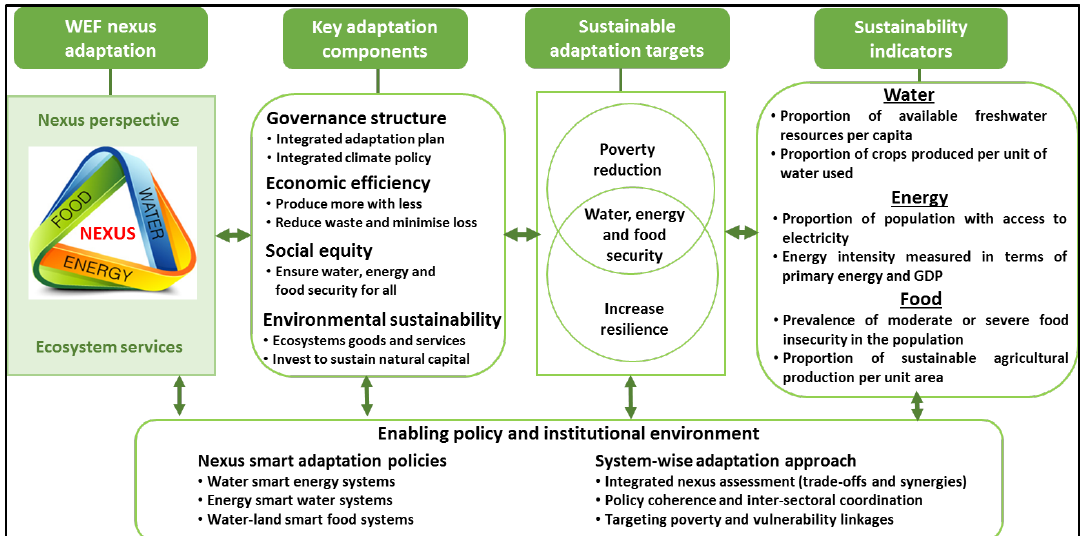
Figure 4. WEF nexus livelihoods adaptation and transformation framework.